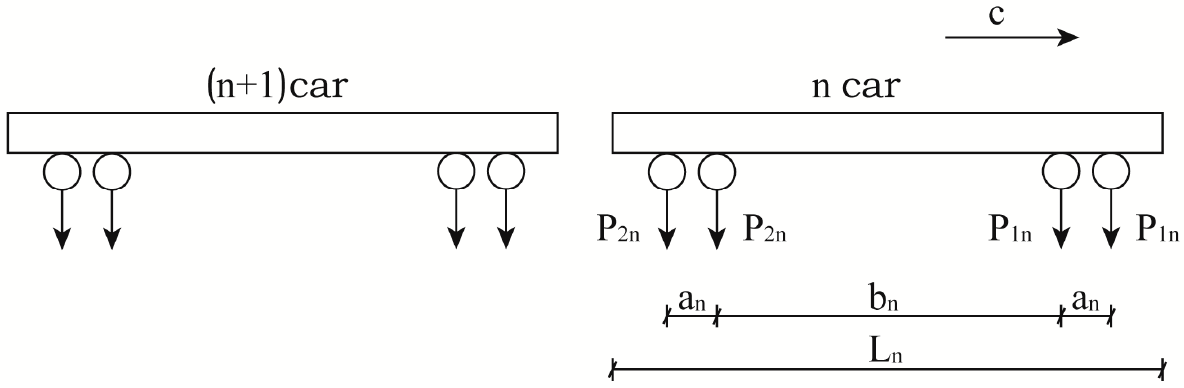
Figure 16. Schematic diagram of train axle load.